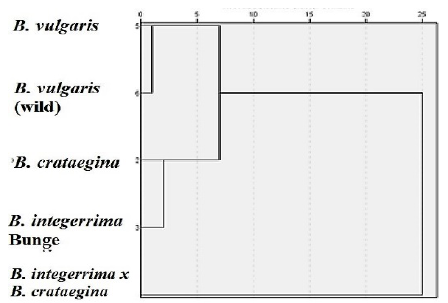
Figure 3. The HCA dendrogram according to the fatty acid compositions of Berberis spp.